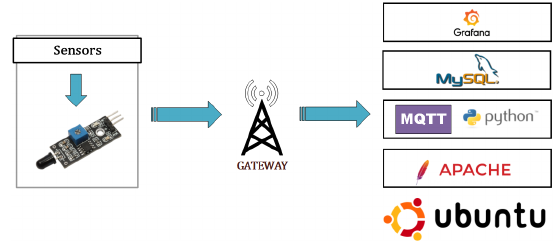
Figure 4. System Architecture Diagram.